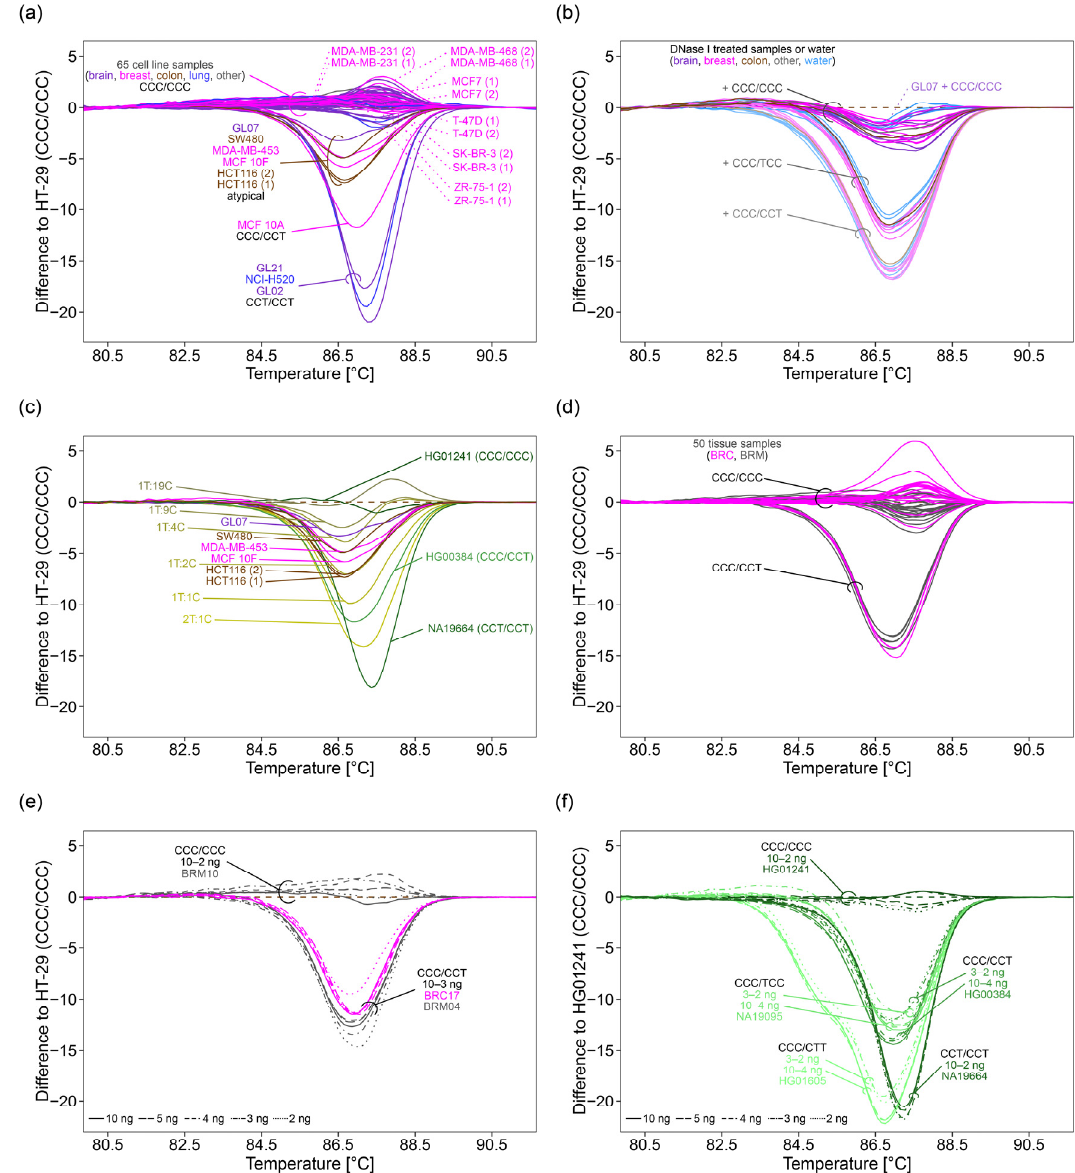
Figure 6. Application of the 3 SNPs assay by HRM analysis on biological samples shown as difference to the triple- homozygous control CCC/CCC of the respective sample set (straight dashed line). ( a ) In 75 cell line samples originating from brain (purple), breast (pink), colon (brown), lung (blue) and other tissues (black), the genotypes CCC/CCC (dark), CCC/CCT (lighter) and CCT/CCT (light) and a group with atypical melting curves between CCC/CCC and CCC/CCT were found. ( b ) Oligonucleotide controls (CCC/CCC (dark), CCC/TCC (lighter), CCC/CCT (light) added to DNase I treated samples (n = 17, n = 6, n = 6, respectively, colored by tissue origin) grouped together with the respective oligonucleotide control added to water (gray, n = 5). ( c ) NHGRI sample mixtures of NA19664 (CCT/CCT) and HG01241 (CCC/CCC) in ratios from 1T:2C to 1:4 (1T:4C) and cell lines having atypical melting curves had similar melting curve shapes. ( d ) In breast cancer (pink) and normal control tissue (gray), the genotypes CCC/CCC (dark) and CCC/CCT (lighter) were found and ( e ) could be distinguished down to 3 ng. ( f ) All 5 variant combinations present in the NHGRI Sample Repository for Human Genetic Research could be distinguished down to 4 ng. ( e , f ) 10 ng (solid), 5 ng (long-dashed), 4 ng (dashed), 3 ng (dot-dashed), and 2 ng (dotted) initial DNA amount for PCR are shown. ( a , b , d , e ) Curves shown in one plot originate from multiple runs. For clarity reasons, the melting curve of one PCR replicate is